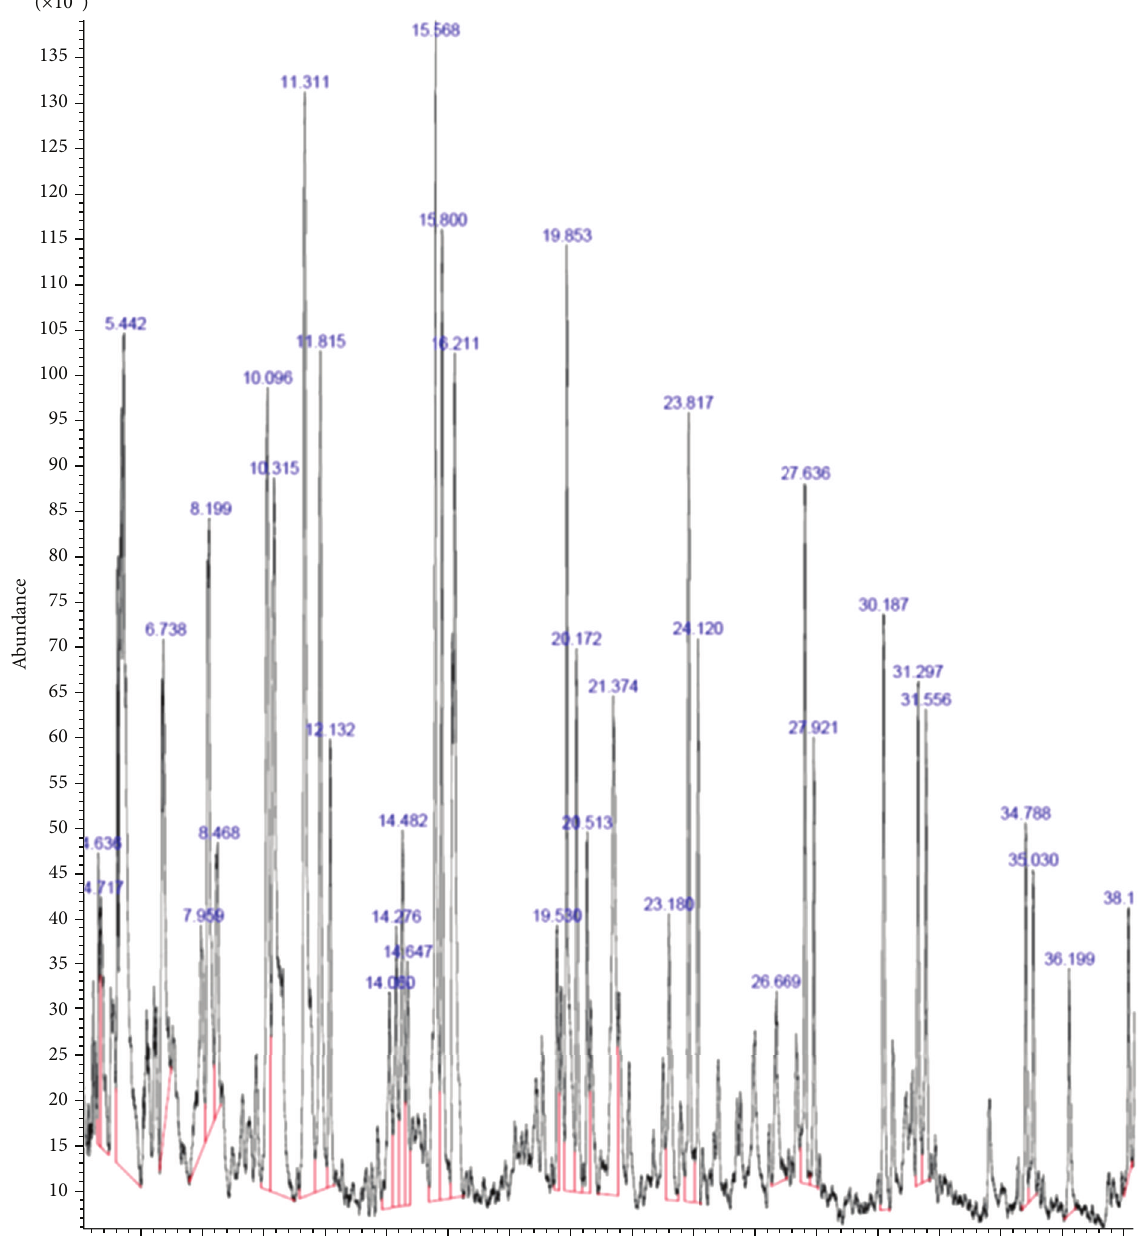
Figure 3: Mass spectrum of plastic oil sample